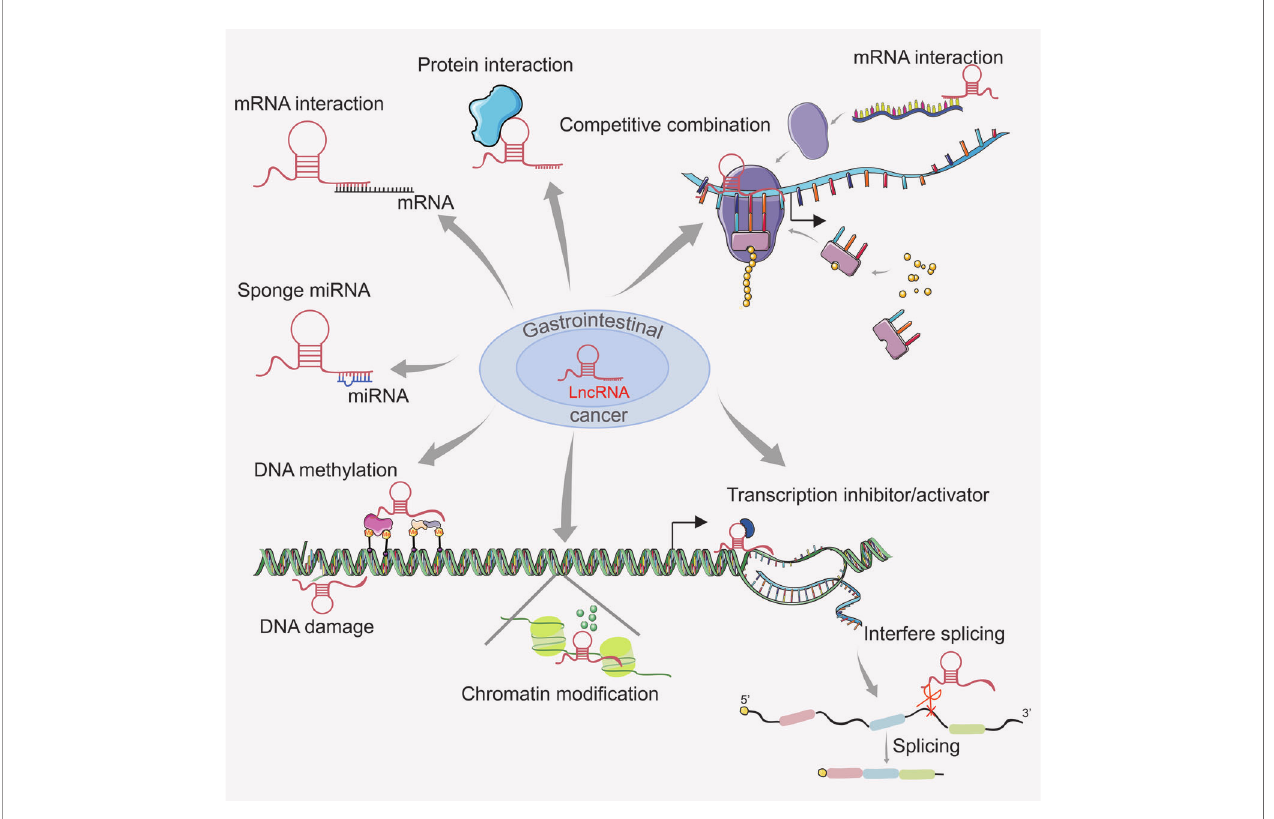
FIGURE 1 | The role of lncRNA in gastrointestinal